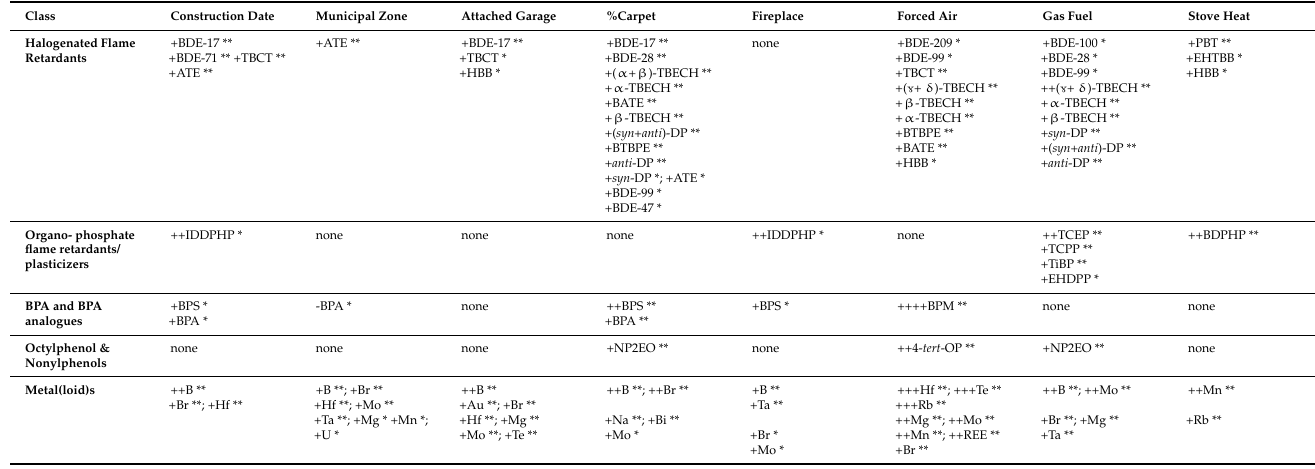
Table 5. Selected contaminants associated with increasing construction date and/or proximity to suburban fringe, and related building characteristics, identified using Spearman rank analysis a . Positive correlations with construction date indicate that concentrations increase in newer homes; positive correlations with municipal zone mean concentrations increase towards suburban fringe. See SI-01 to SI-02 for all Spearman rank